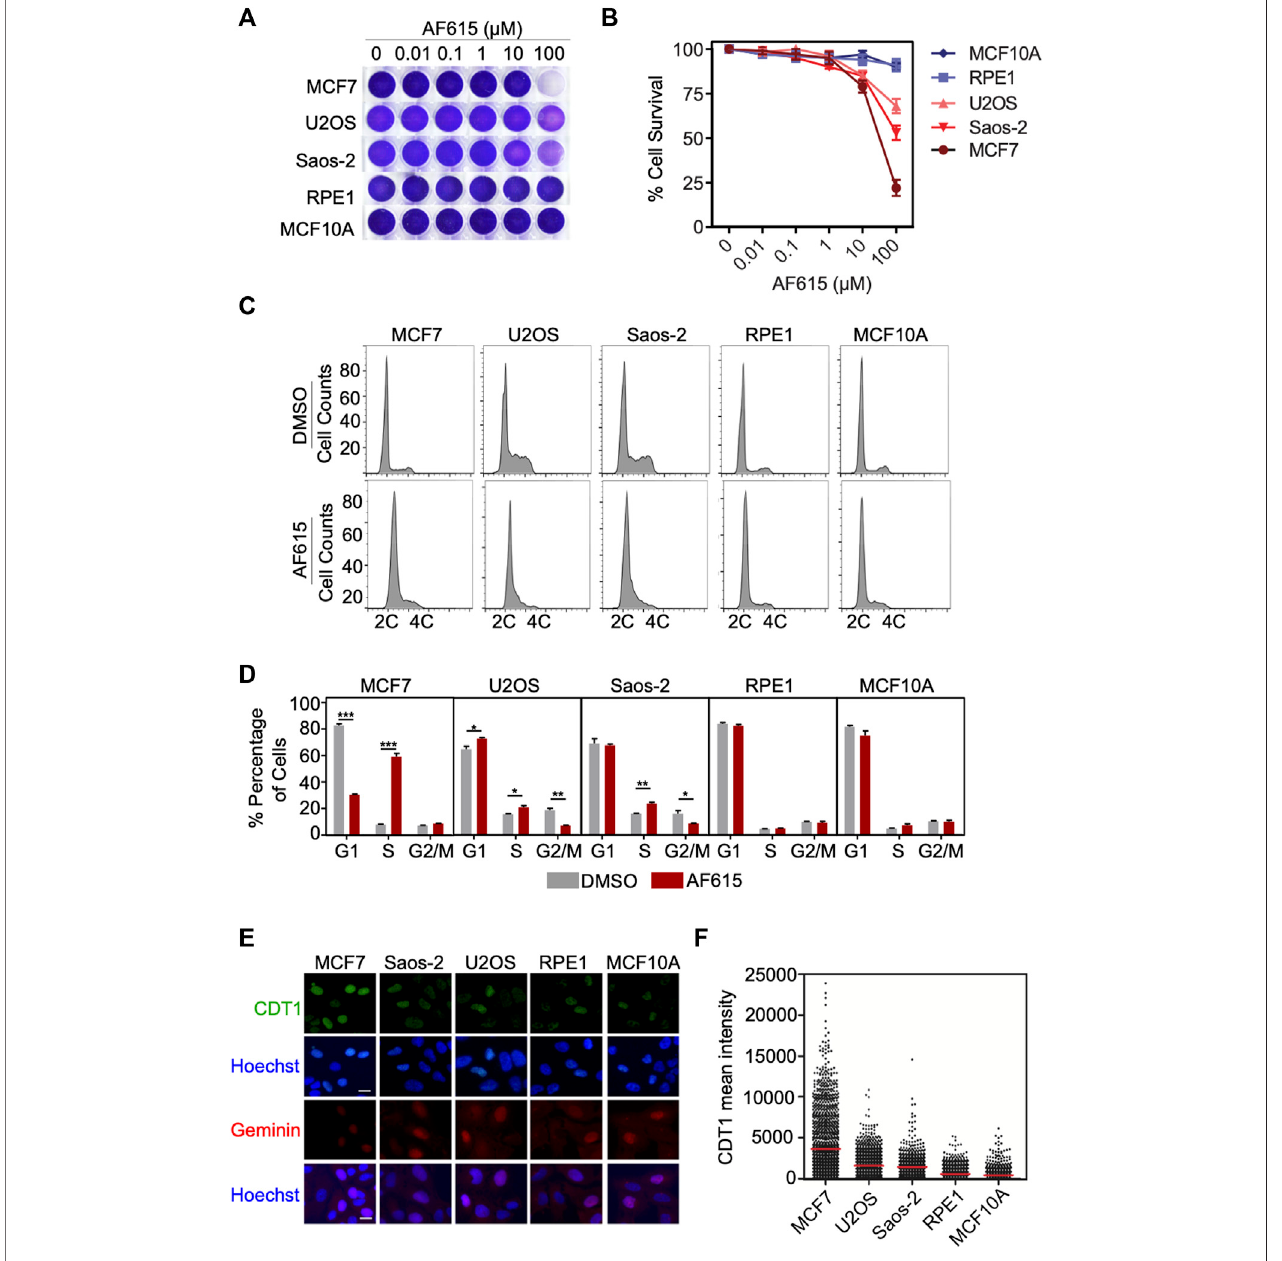
FIGURE4| CancercellsexhibitincreasedsensitivitytochemicalcompoundAF615. (A) SurvivalassayforMCF7,U2OS,Saos-2,MCF10A,RPE1cellstreatedwith increasing concentrations of compound AF615 for 3 days. Cells stained with crystal violet. (B) Quanti fi cation of cell survival from n = 3 biologically independent experiments. (C) Flow cytometry (FACs) pro fi les of MCF7, U2OS, Saos-2, MCF10A and RPE1 cells treated with compound AF615 (100 μ M) for 24 h. DNA content analysis was performed using propidium iodide (PI). Representative fl ow cytometry pro fi les of three biologically independent experiments are shown. 2C and